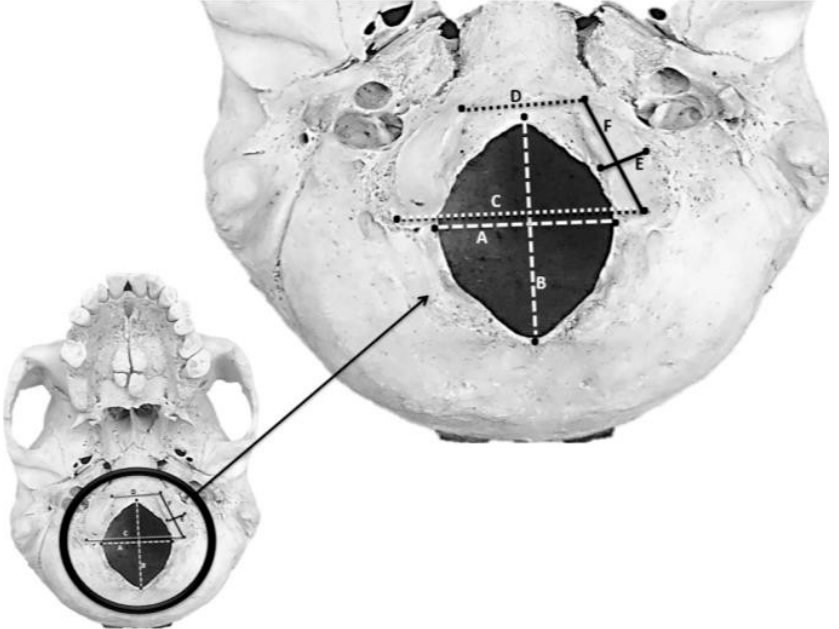
Figure 1. Anatomical landmarks of the foramen magnum and occipital condyles: ( A ) maximum transverse diameter of the foramen magnum, ( B ) maximum anteroposterior diameter of the foramen magnum, ( C ) posterior tip of occipital condylar width, ( D ) anterior tip of occipital condylar width, ( E ) maximum transverse length of occipital condyles and ( F ) maximum anteroposterior length of occipital condyles.